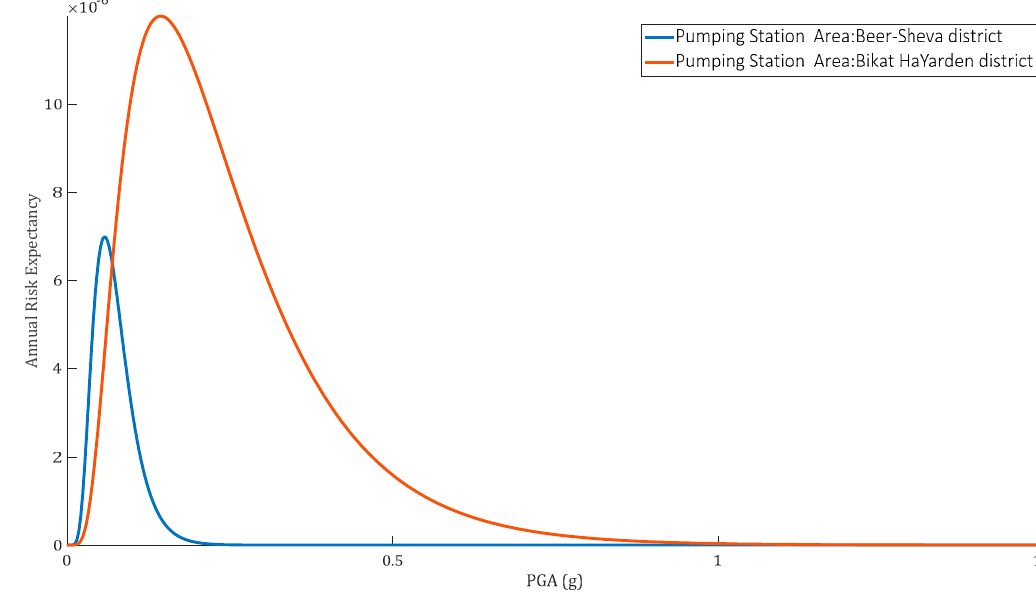
Figure 4. Risk curve for Be’er Sheva and Bik’at HaYarden regions.